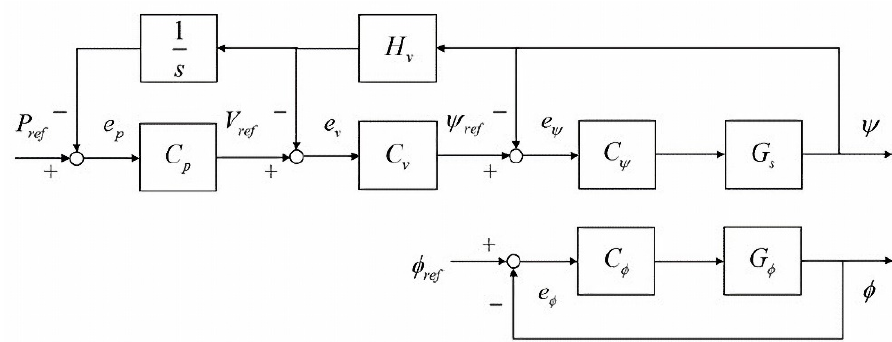
Figure 11. The multi-loop control structure.